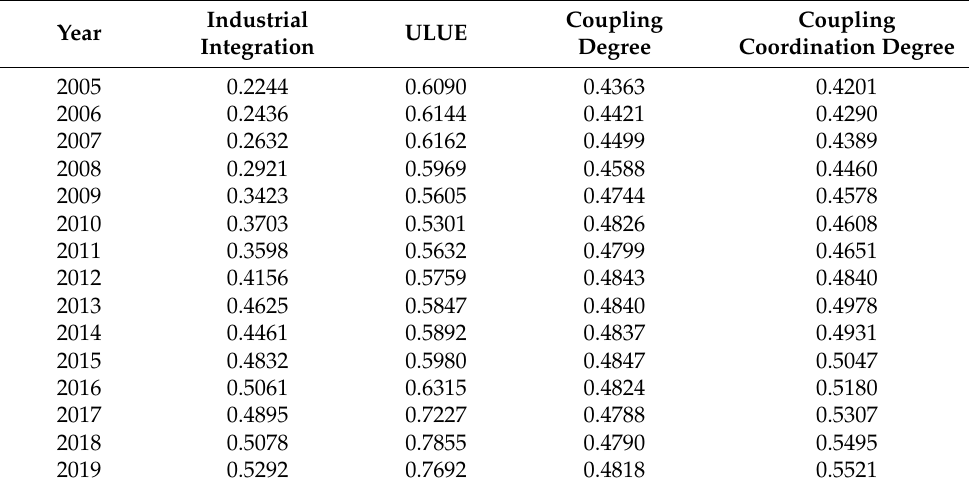
Table 4. Coupling coordination degree of “industrial integration–ULUE”